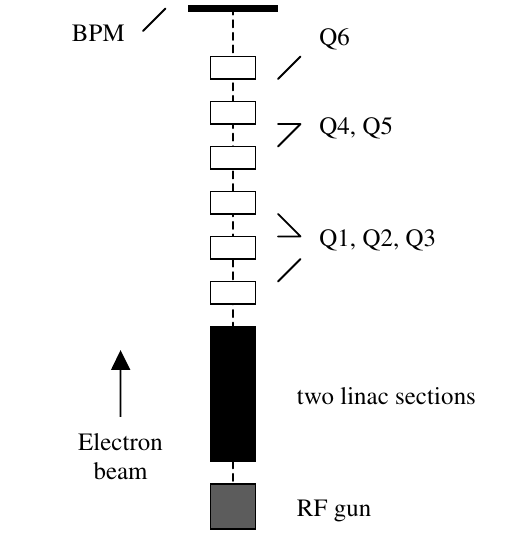
FIG. 1. Schematic layout for emittance